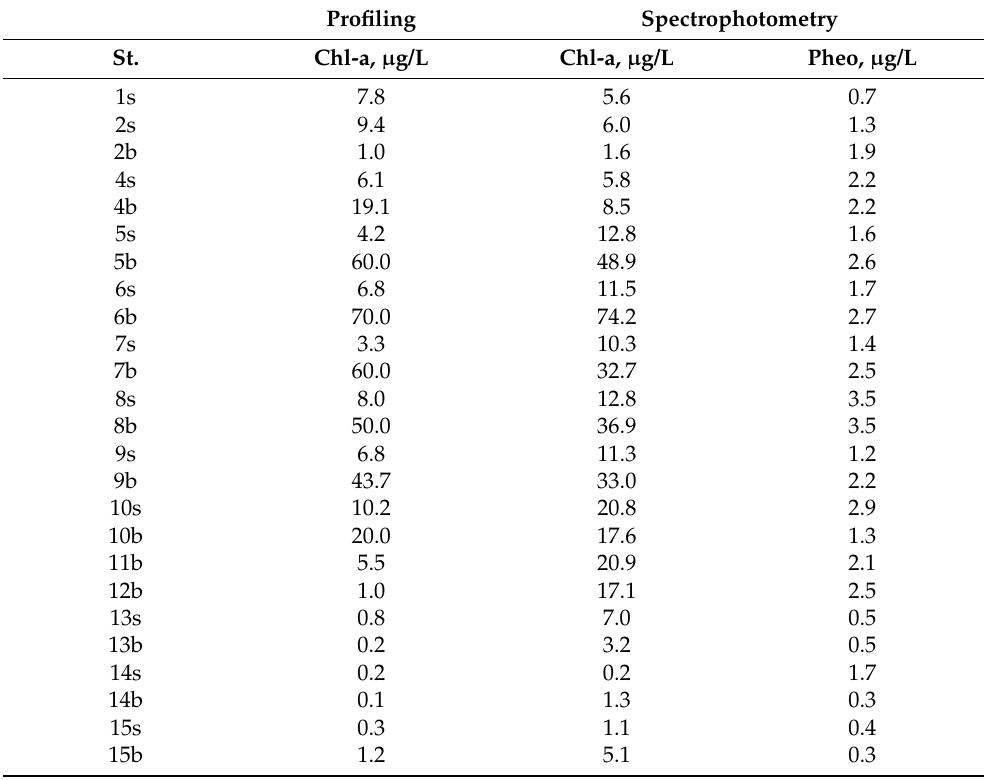
Table 2. Chl-a and pheophytin concentrations obtained by profiling and spectrophotometry for the Feb. 23 survey samples. The “s” and “b” subscripts denote the surface and the bottom layer of water, respectively. Profiling Spectrophotometry St. Chl-a, µ g/L